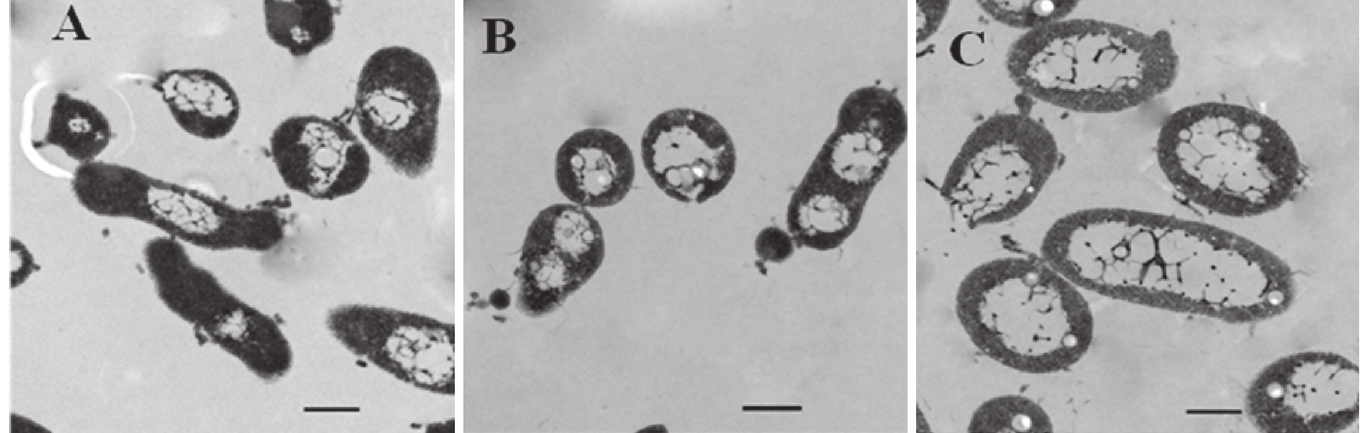
Fig 3. Thin section electron micrographs of Natrinema sp. J7-2 for cells incubated in media with different salinity. (A) cells incubated in 18% medium; (B) cells incubated in 25% medium; (C) cells incubated in 30% medium. The scale bars represent 500 nm.